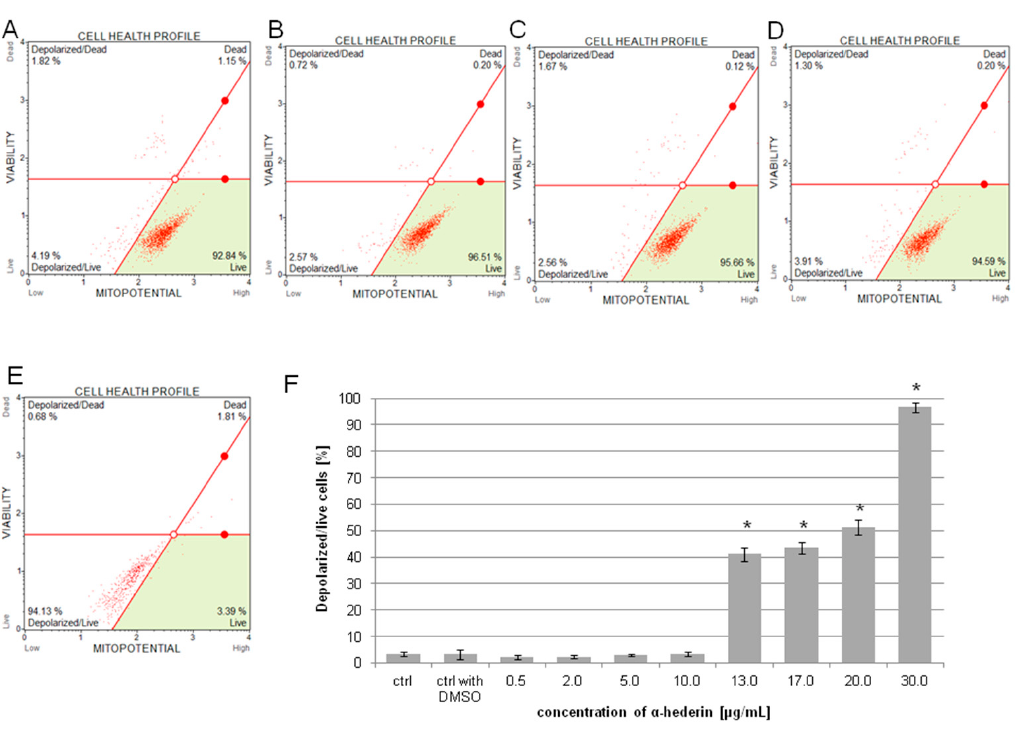
Figure 6. α -HN triggered alterations in the inner transmembrane mitochondrial potential in SKOV-3 cells. The loss of potential was determined after 3 h in untreated SKOV-3 cells (control), in the cells treated with 0.5% DMSO (control with DMSO) ( A ), and within the cells treated with increasing concentrations of α -HN in the range 0.5–30 µ g / mL (particular concentrations are represented in pictures: 0.5 ( B ), 2 ( C ), 10 ( D ), and 30 µ g / mL ( E )). The measurement of SKOV-3 mitochondrial depolarization was evaluated in relation to the 0.3% DMSO control ( F ). Each sample was run three times, independently. Standard deviation is represented by error bars. Significant differences relative to the control are marked with an * ( p < 0.05).